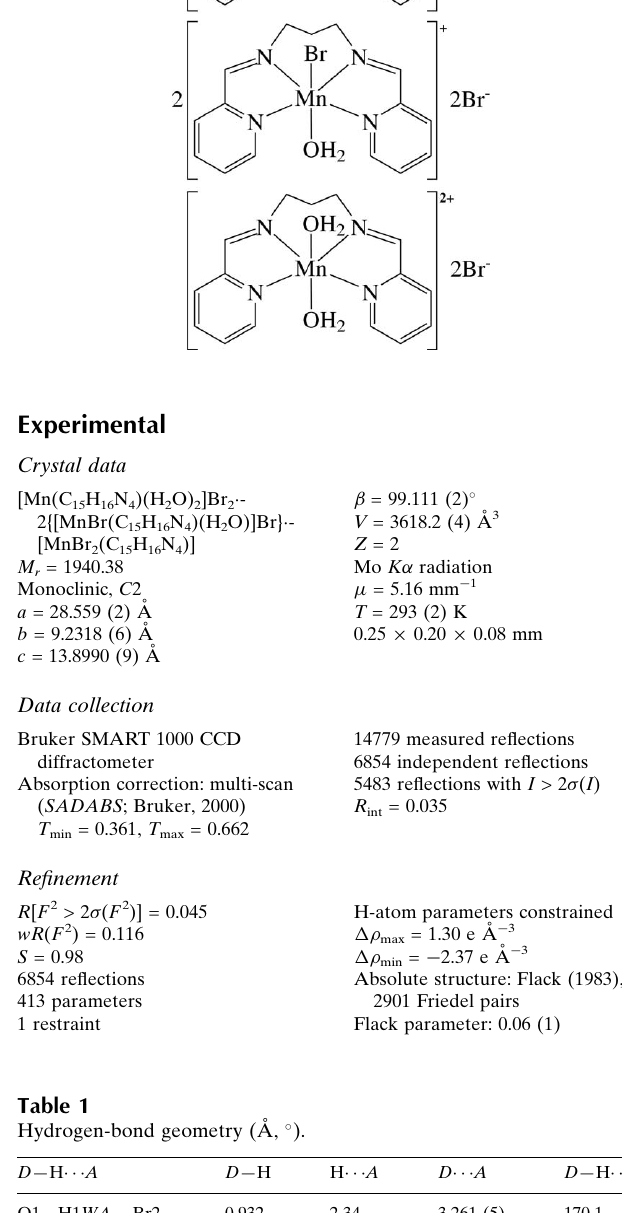
For a structurally related complex, see: Hwang & Ha (2007).